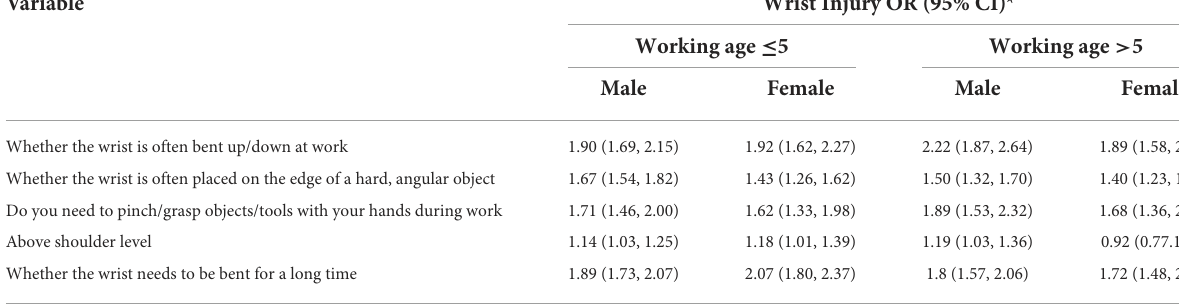
TABLE 5 Logistic regression was used to evaluate the effect of wrist posture on wrist injury by gender and length of service. Variable